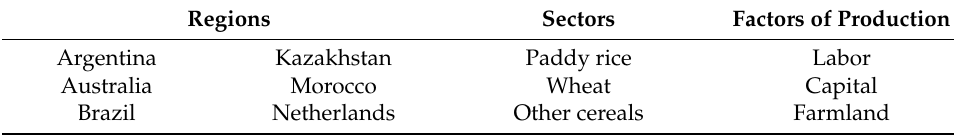
Table 1. Regional, sectoral and factor aggregations in the model. Regions Sectors Factors of Production Labor Wheat Capital Other cereals